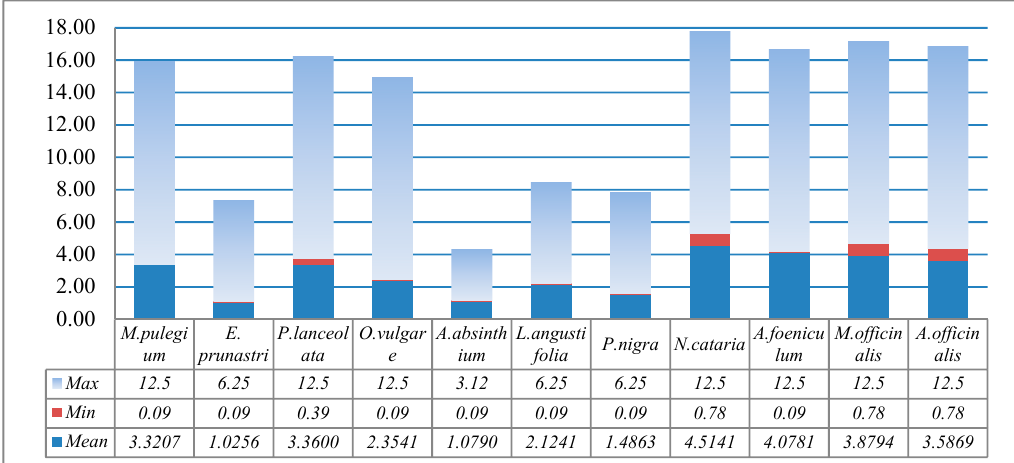
Figure 1. Minimum inhibitory concentrations (MIC) values (mg/mL) for 11 plant extracts.